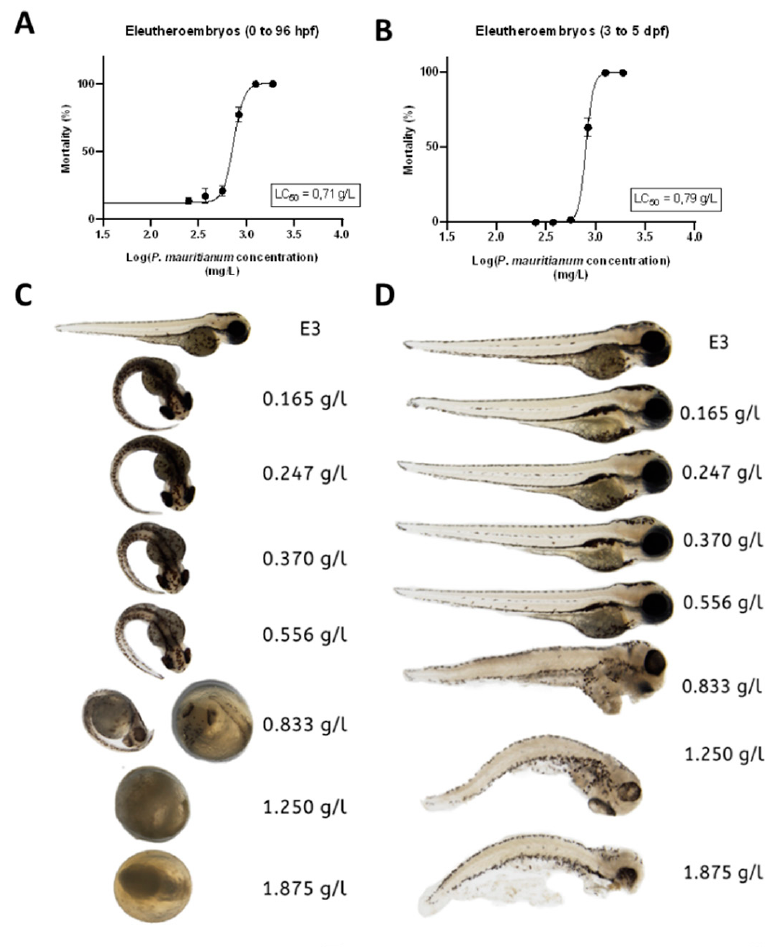
Figure 2. Determination of the lethal concentration 50 (LC 50 ) of the aqueous extract of P. mauritianum on eleutheroembryos. ( A , B ): Survival curve showing the mortality percentages of eleutheroembryos (3 hpf to 96 hpf and 3 dpf to 5 dpf, respectively) treated with 1.87 g/L, 1.25 g/L, 0.83 g/L, 0.55 g/L, 0.37 g/L, 0.24 g/L and 0.16 g/L of the aqueous extract from P. mauritianum , as a function of the log P.